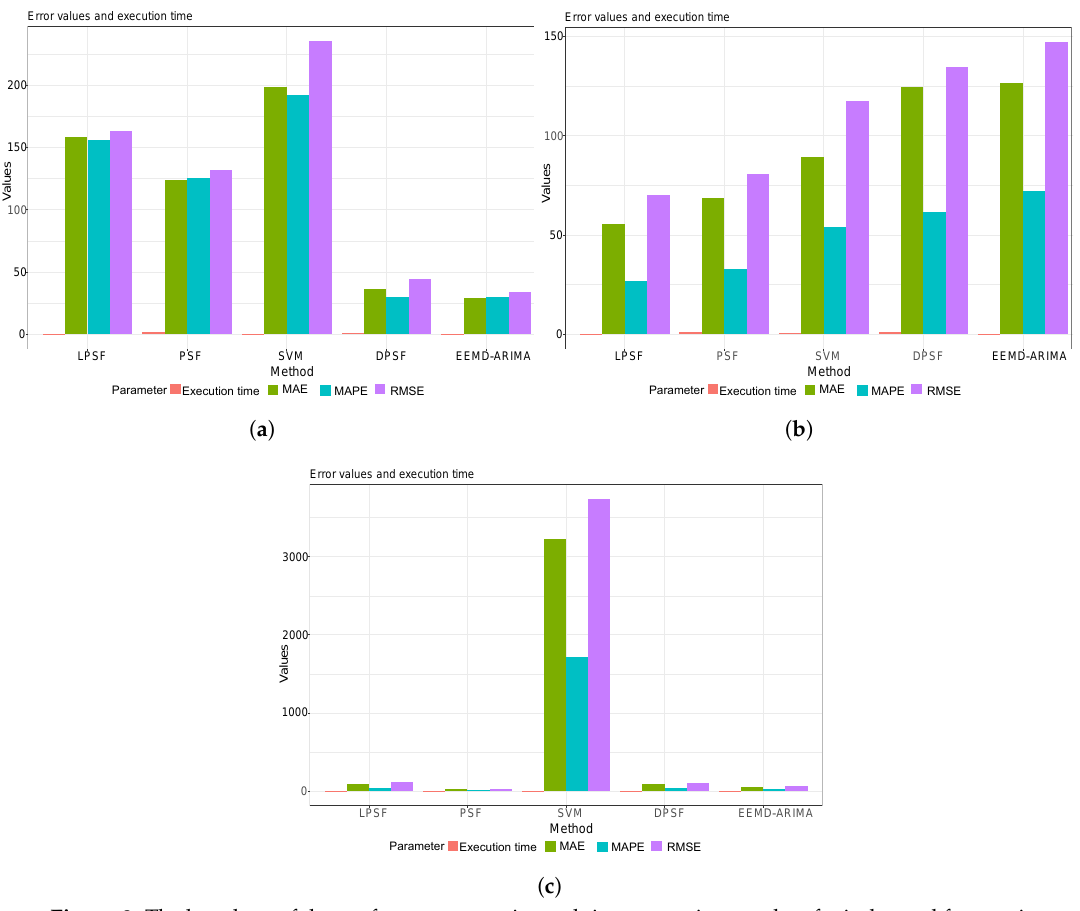
Figure 8. The bar chart of the performance metrics and time execution results of wind speed forecasting for the daily ( a ), weekly ( b ) and monthly ( c ) at Watford City